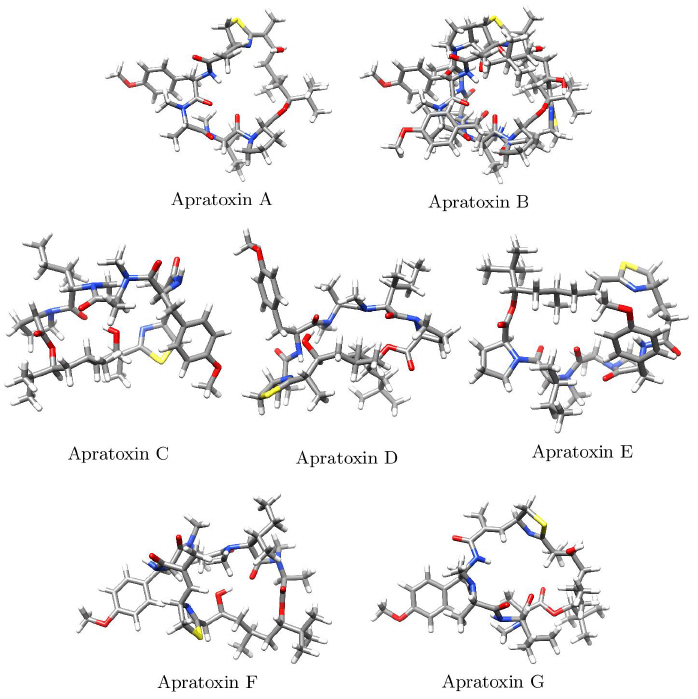
Figure 2. Optimized molecular structures of Apratoxin A, Apratoxin B, Apratoxin C, Apratoxin D, Apratoxin E, Apratoxin F and Apratoxin G. Table 1. Frontier orbital energies, HOMO-LUMO gap and the KID descriptors for the Apratoxins A–G family of marine cyclopeptides (all in